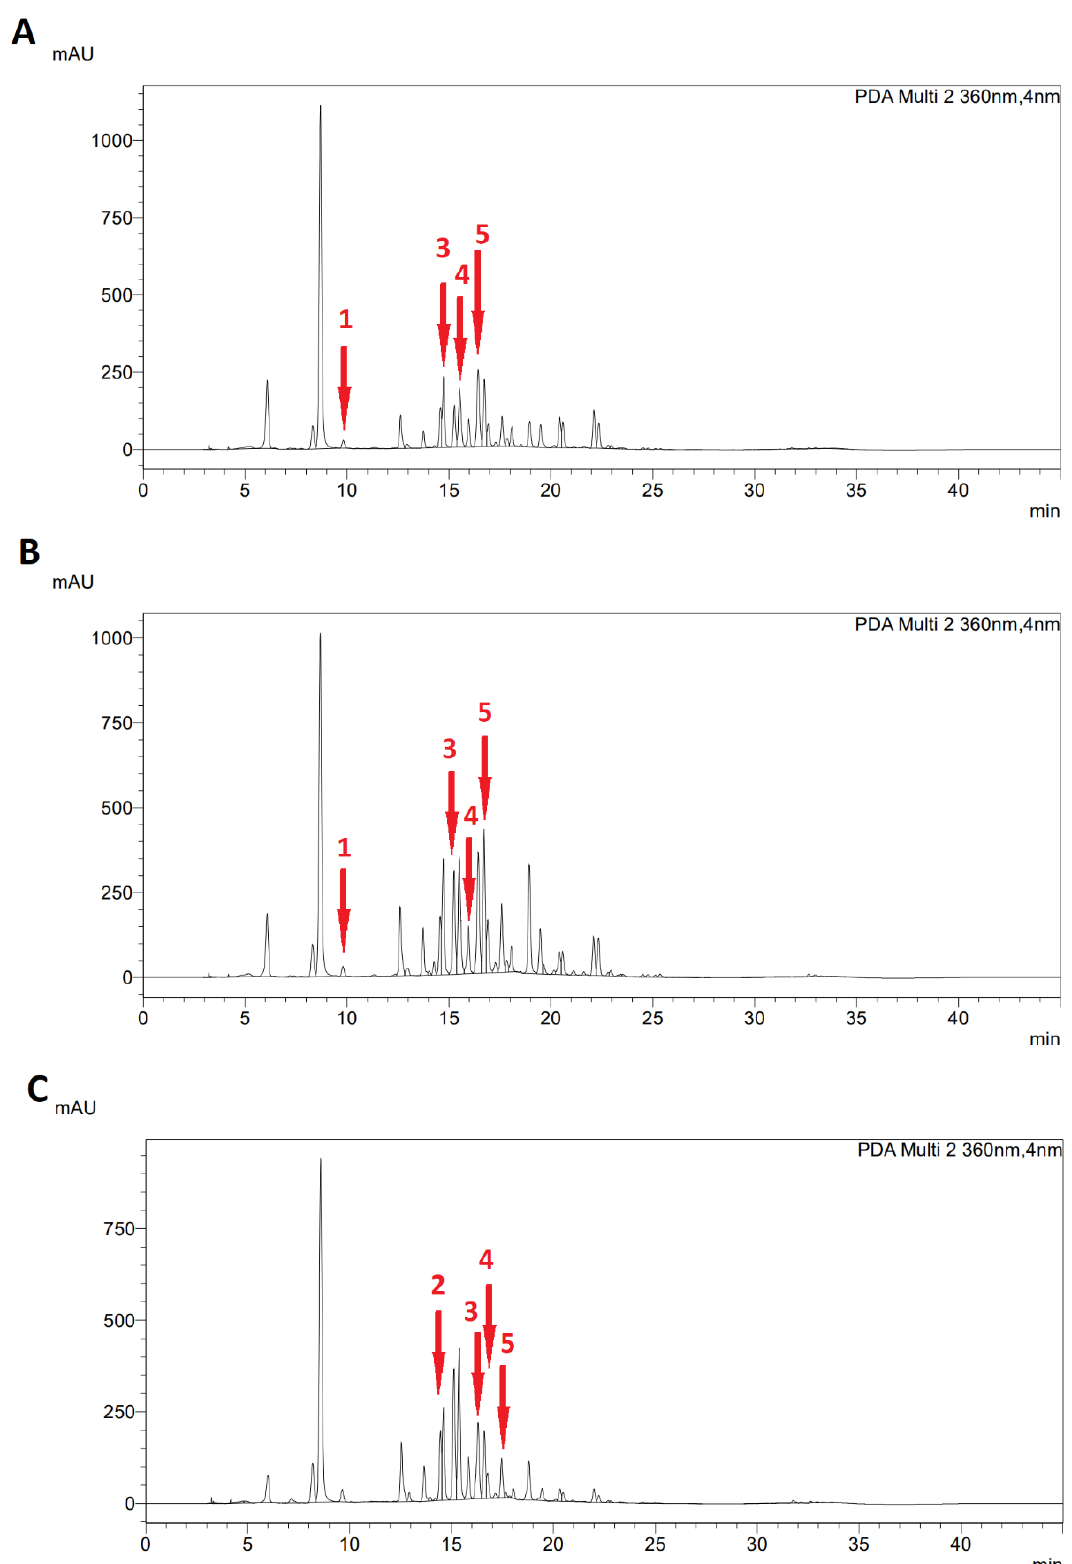
Figure 6. HPLC chromatogram of phenolic compounds profile of Sylphium perfoliatum L. at ( A ) pre- flowering, ( B ) flowering, and ( C ) end of flowering stage; 1 — caffeic acid, 2 — coumaric acid, 3 — ellagic acid, 4 — ferulic acid, and 5 — naringin.